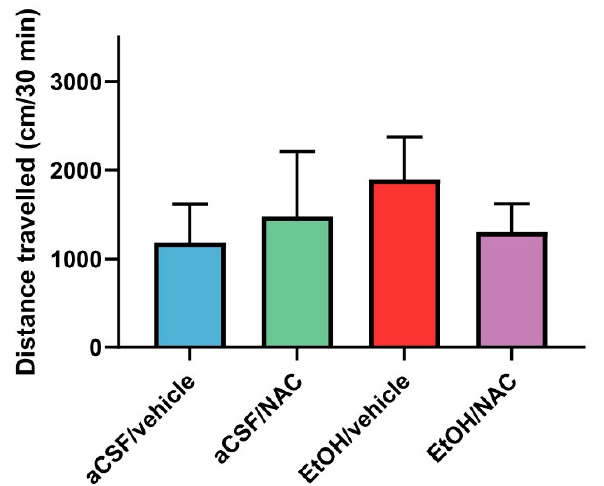
Figure 4. The effects of NAC administration (120 mg/kg), 30 min prior to the intra-VTA administration of EtOH (150 nmol), on the locomotor activity of rats. Data are mean ± SD and represent the distance traveled in 30 min. The Kruskal–Wallis test revealed no statistical differences between the groups.